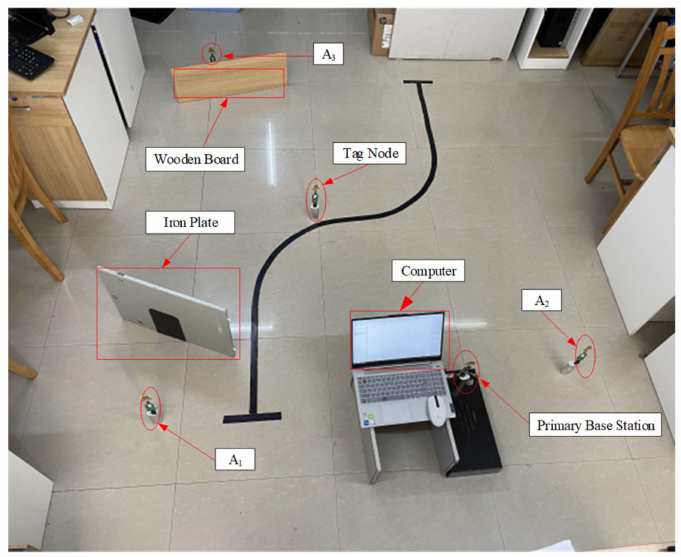
Figure 6. Environment of the static positioning